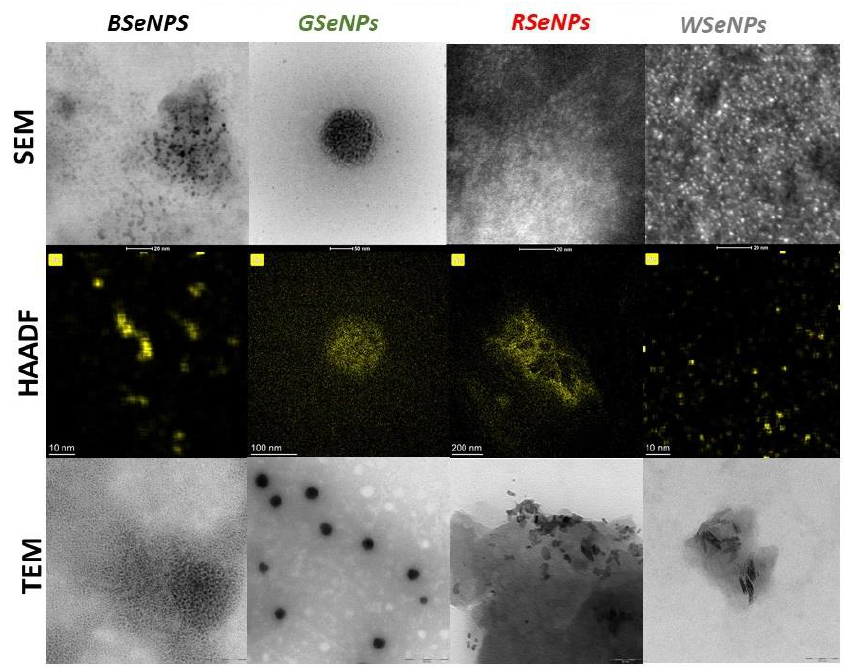
Figure 3. SEM, TEM and TEM (HAADF STEM) of obtained selenium nanoparticles. Abbreviations: BSeNPs—nanoparticles synthesized using black tea infusions, GSeNPs—green tea, RSeNPs—red tea BSeNPs — nanoparticles synthesized using black tea infusions, GSeNPs — green tea, RSeNPs — red tea and WSeNPs — white tea infusion. and WSeNPs—white tea